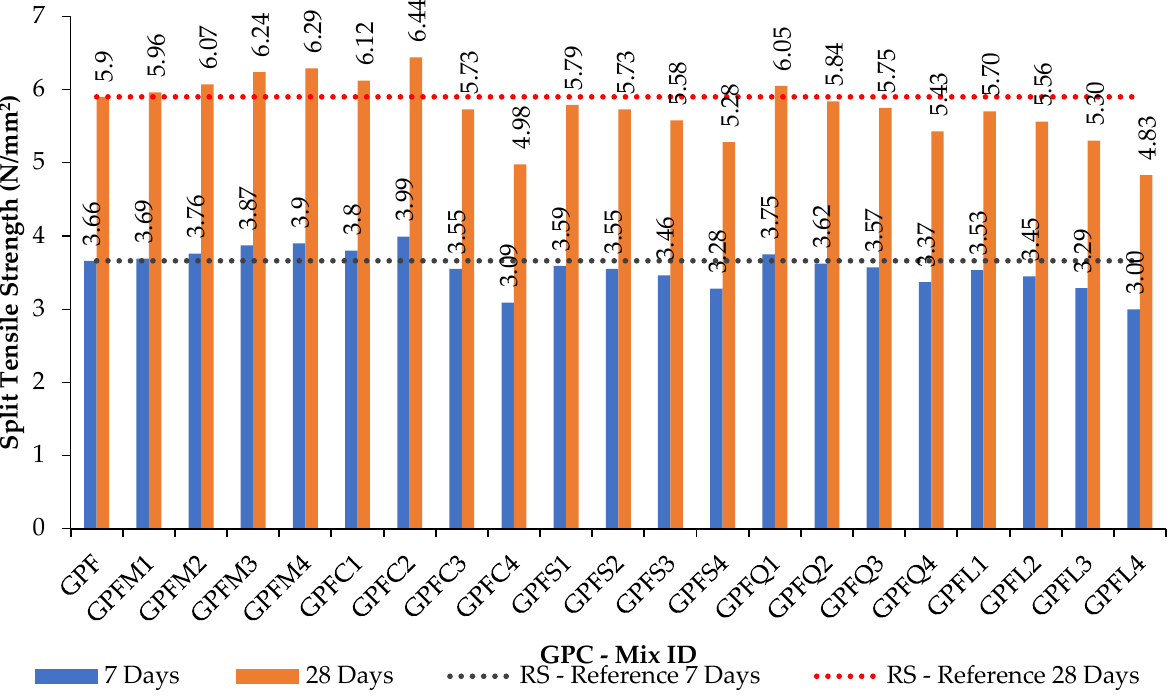
Figure 6. The 7- and 28-day split tensile test results for M 40 GPC with various fine aggregates.